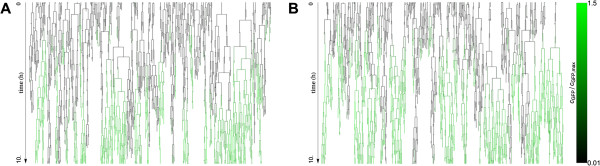
Lineage tree of an induced population of cells in the stochastic model. Linage tree of a population of cells induced at a fixed autoinducer concentration cA∗=50nM for the lux01 operon (left) and the lux02 operon (right). Vertical lines represent individual cells and horizontal lines cell division events. The color of the lines is proportional to the normalized GFP expression. The initial number of cells is 100 and is kept constant during the experiment by “deleting” cells at random every time a cell divides (truncated vertical lines). The lineage tree shows how the state of the cell is transmitted over generations and reveals that once the operon is activated the transition is “irreversible”.